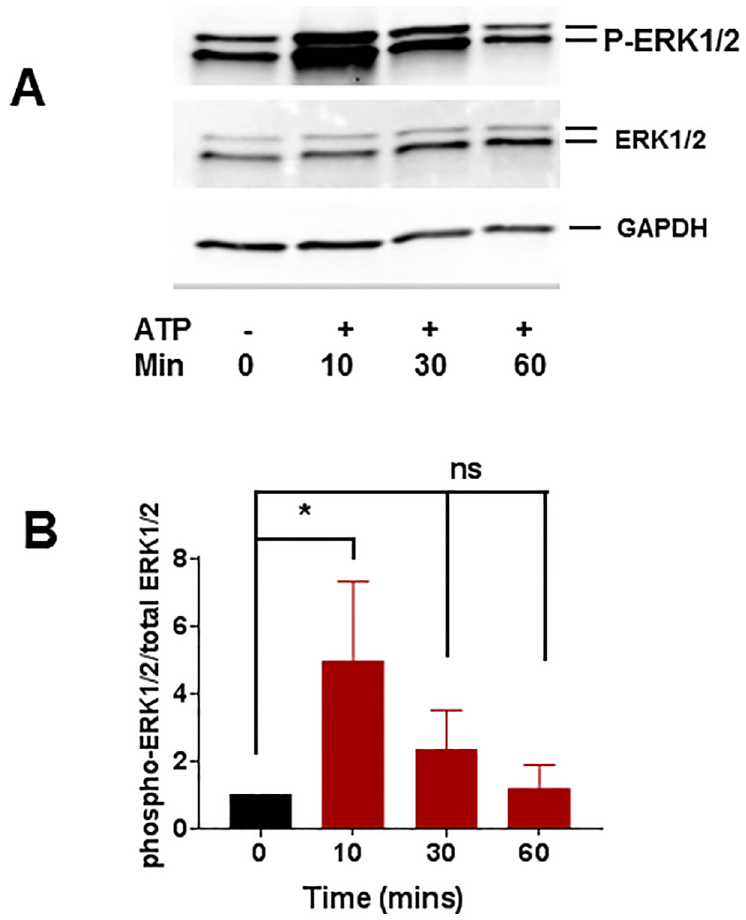
Fig 5. Time course of phosphorylation of p-ERK1/2 MAPK in ATP treated HSVEC. HSVEC were untreated (0) treated with ATP (2 mM) for various time points (10, 30, and 60 minutes) and phosphop44/42 MAPK (P-ERK1/2) and total p44/42 (ERK1/2) proteins were quantitated with immunoblotting (adjustedto the loadingcontrol GAPDH). ( A ) Representative western blot of phosphoERK1/2, (B ) Cumulative data showing the phosphorylation (fold) of p ERK1/2 MAPK, * p < 0.05, N = 4, (One way ANOVA).